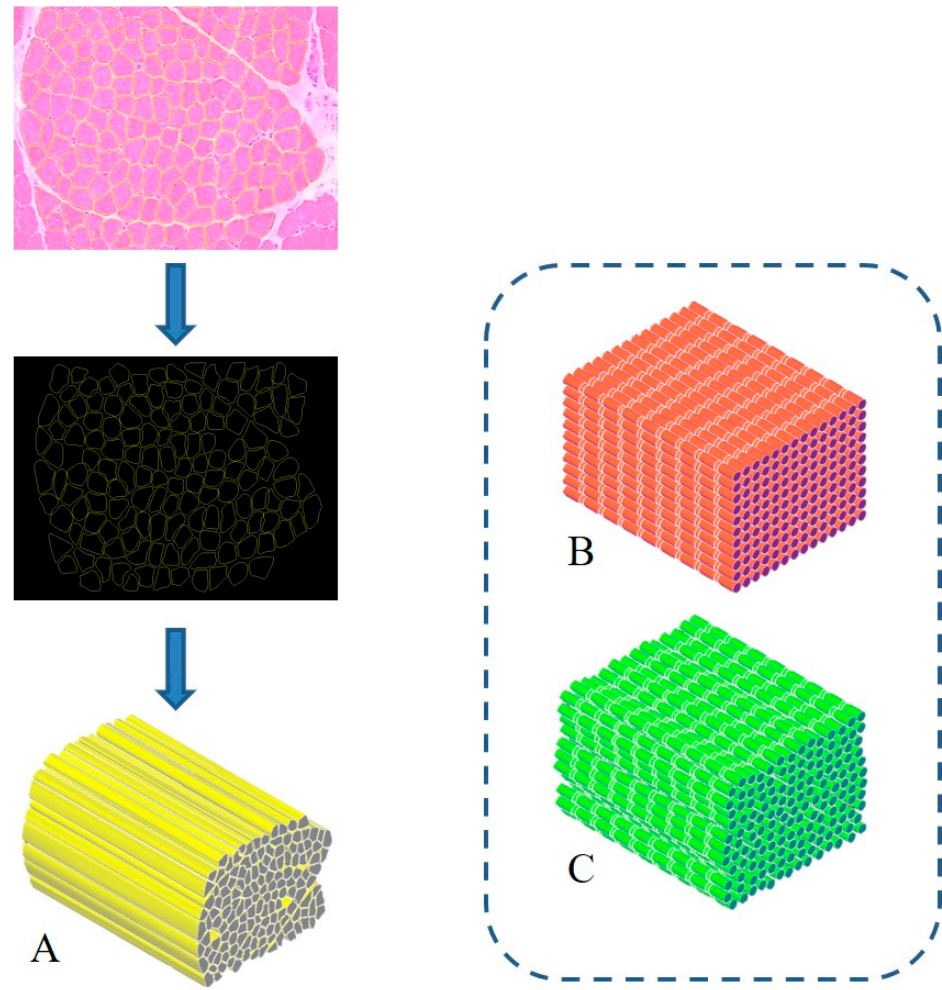
Figure 1. Biomimetic design of sca ff old for skeletal muscle (SM) tissue engineering. A